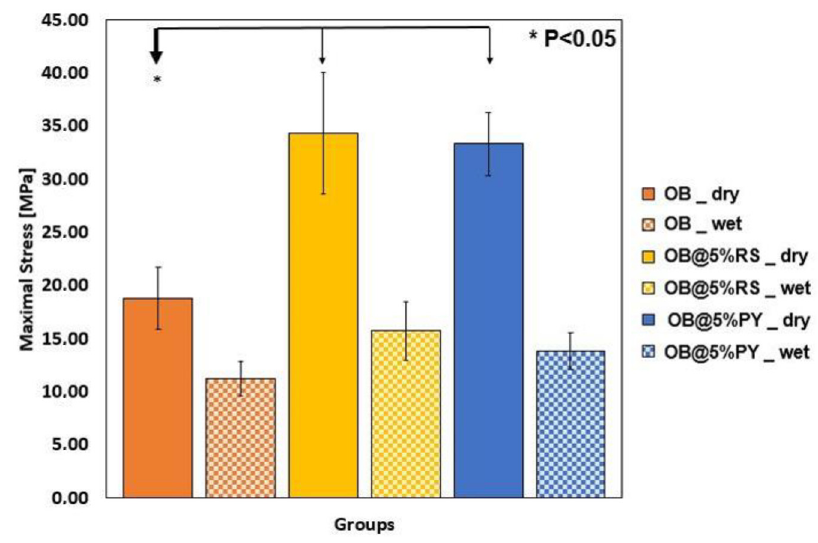
Figure 8. Evolution of maximal stress under compression for OB, OB@5%RS and OB@5%PY in dry conditions; and after immersion in water for 72 h. * p < 0.05 bold arrow.